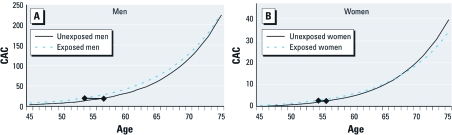
Predicted CAC from multivariable regression of ln(CAC+1) on age and sex: men (A) and women (B). The diamonds represent the estimated difference in vascular age between SHS-exposed participants and unexposed participants.